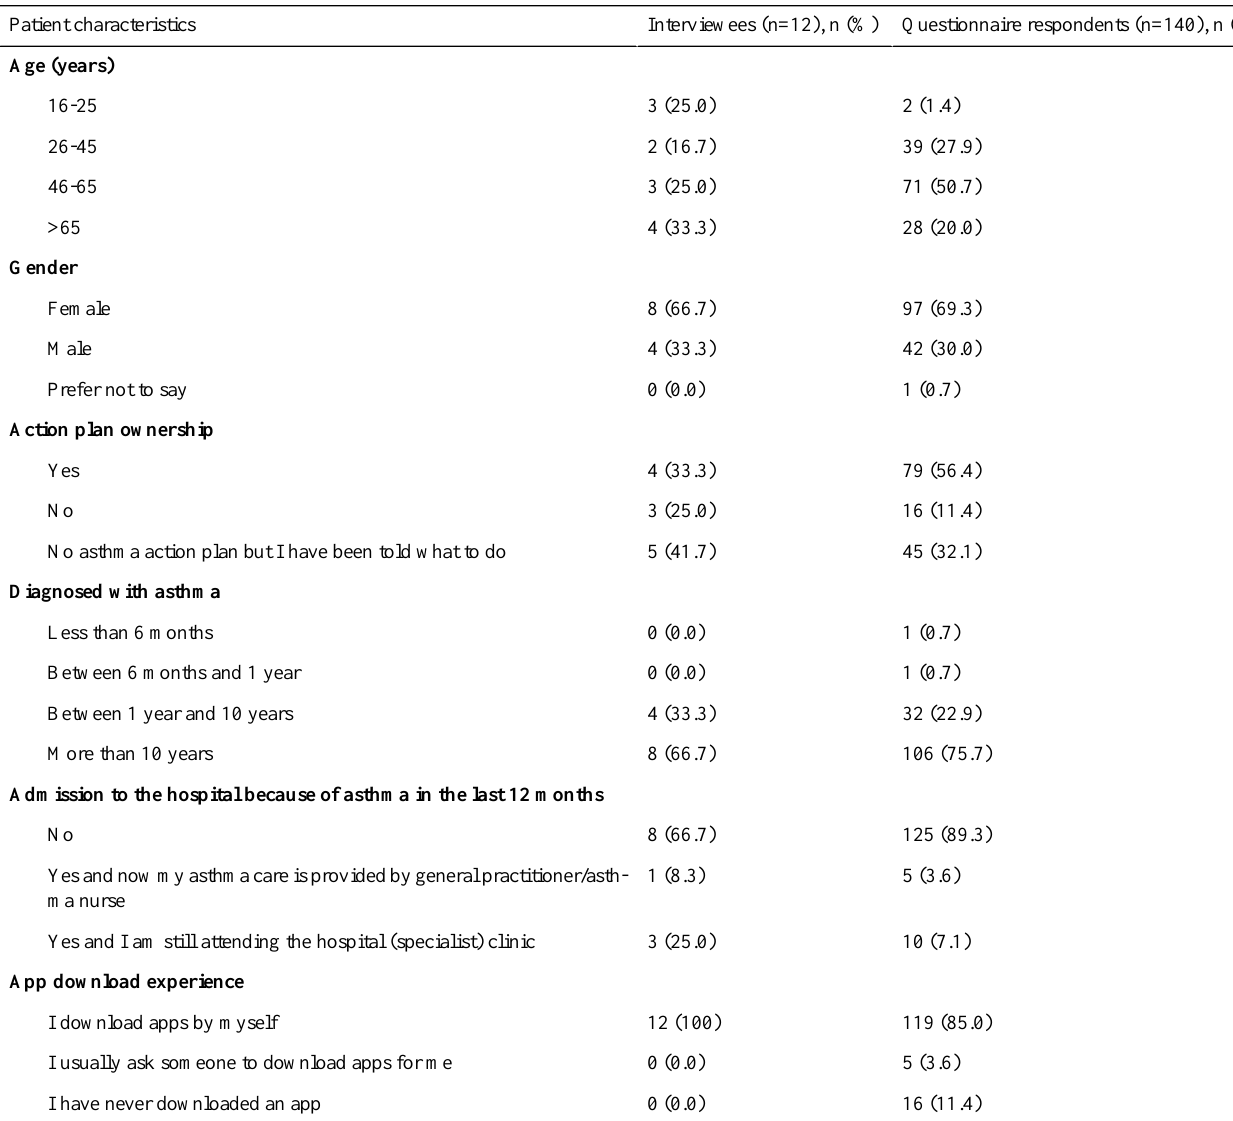
Table 2. Characteristics of patient